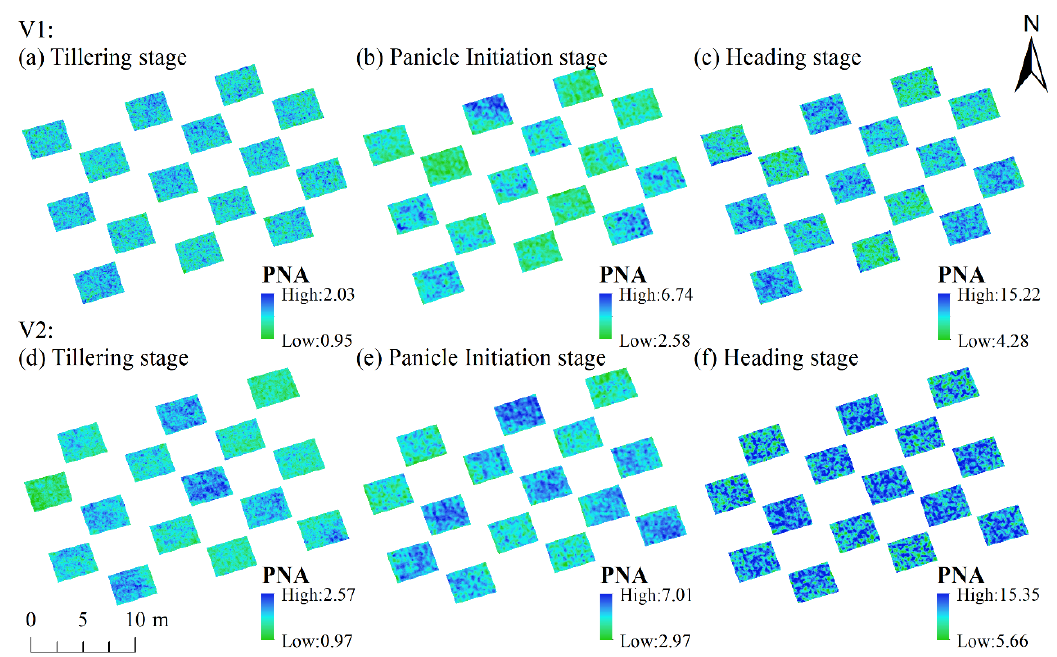
Figure 8. Rice plant nitrogen accumulation (PNA) distribution maps of the study area for rice variety V1 (Meixiangzhan 2) at ( a ) the tillering stage, ( b ) panicle initiation stage, and ( c ) heading stage; and for variety V2 (Wufengyou 615) at ( d ) the tillering stage, ( e ) panicle initiation stage, and ( f ) heading stage.